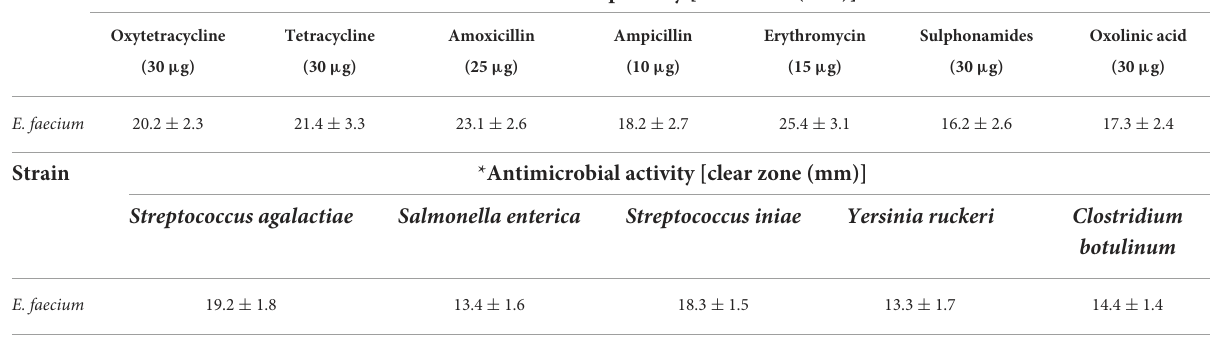
TABLE 1 Antibiotic susceptibility of isolated Enterococcus faecium against the high consumption antibiotics performed by disk diffusion assay and antimicrobial activity of isolate against the pathogenic